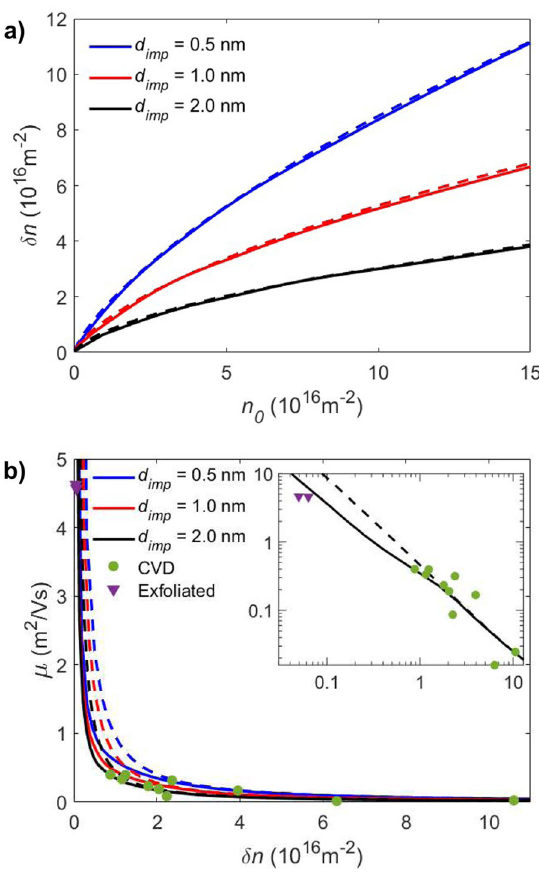
Fig. 3 Mobility and conductivity characteristics of graphene devices. a Dependence of the FWHM of resistivity, δ n , on impurity density, n 0 , for different stand-off distances d imp = 0.5nm (blue curves), 1.0nm (red curves), 2.0nm (black curves). b Calculated mobility, μ , vs. the full width at half maximum (FWHM), δ n , curves (dashed and solid curves) compared to data from pristine graphene samples grown by chemical vapour deposition (CVD) ( fi lled circles) or exfoliated ( fi lled triangles). The dashed lines are obtained from the linearised Boltzmann (LB) approximation, using Eq. (8), the solid lines are obtained using the Discontinuous Galerkin (DG) simulations.